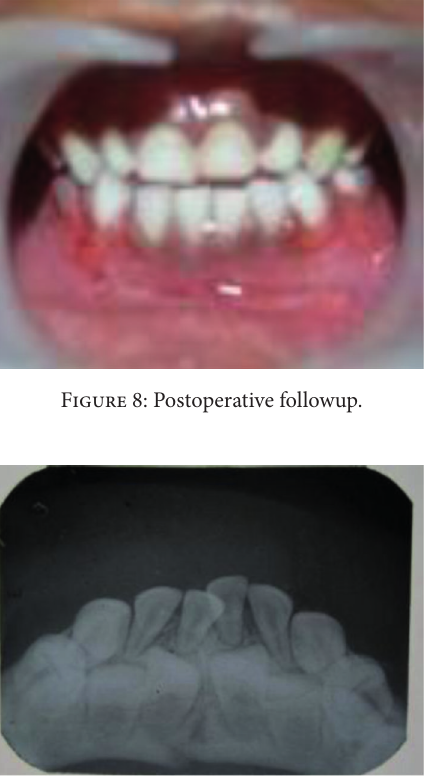
Figure 6: Intraoperative photograph showing splint in position, secured with circummandibular wires.